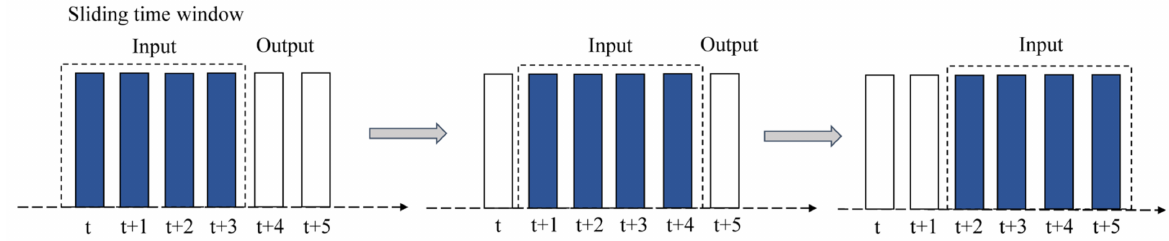
Figure 7. Dynamic modeling process.